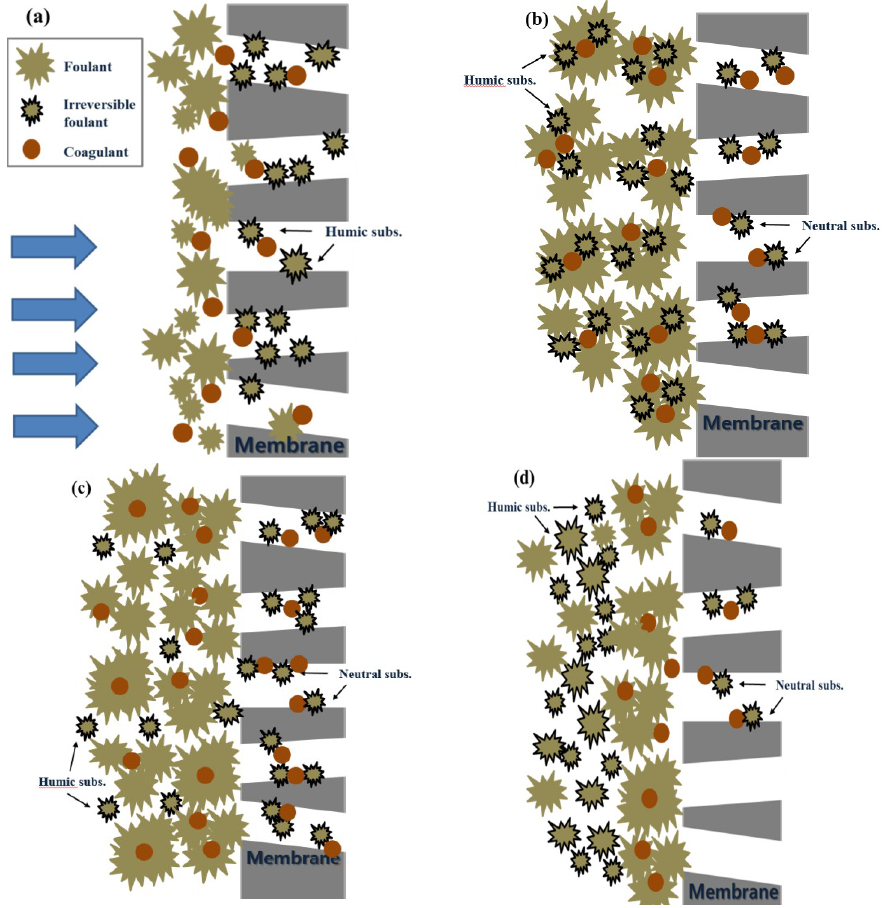
Figure 8. Formation and reduction mechanism of irreversible fouling under each coagulation condition: ( a ) A; ( b ) C; ( c ) D; and ( d ) B.